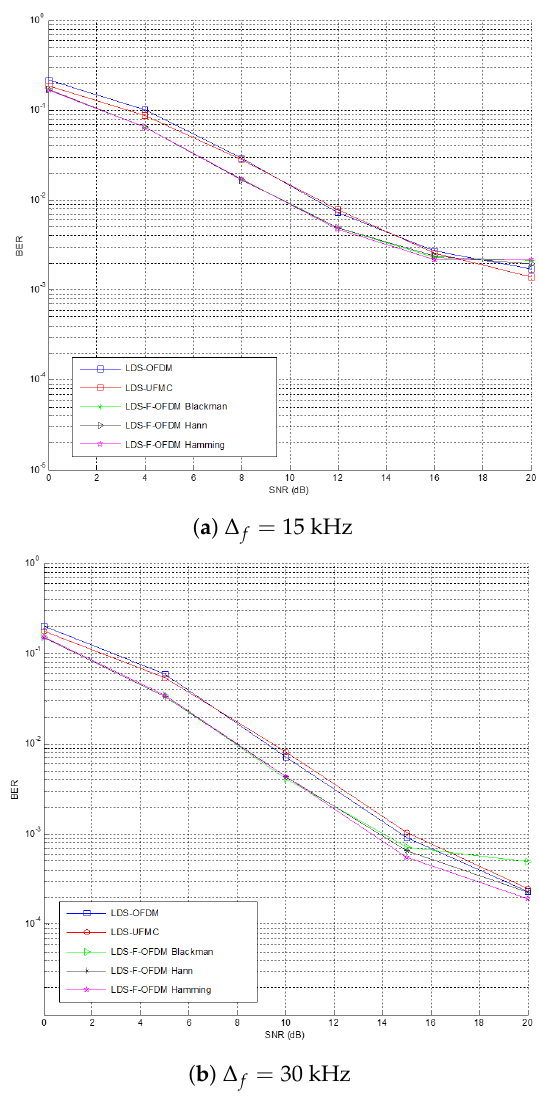
Figure 6. Performance of the proposed schemes over an EVA channel with speed of 300